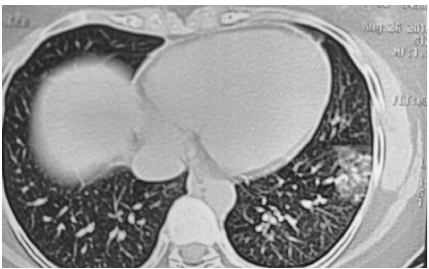
Figure 7: HRCT showing recurrence of bilateral patchy lesions in different zones.